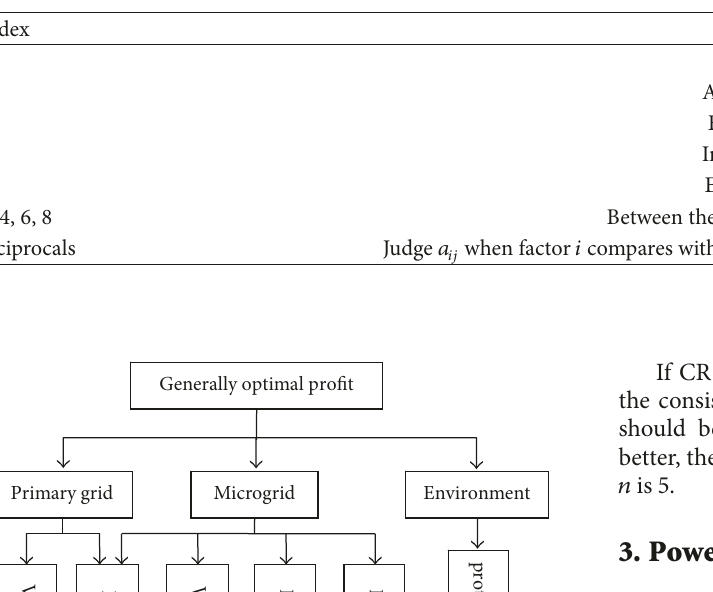
Table 2: Forming rules of the judge matrix.